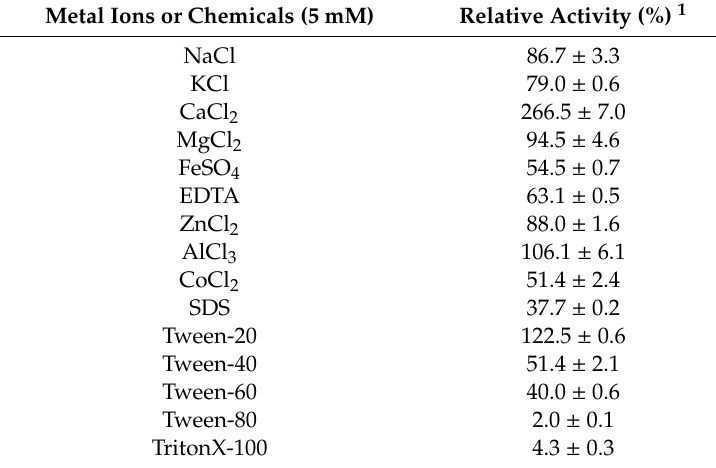
Table 1. E ff ect of various metal ions and chemicals on the activity of PpPel9a.